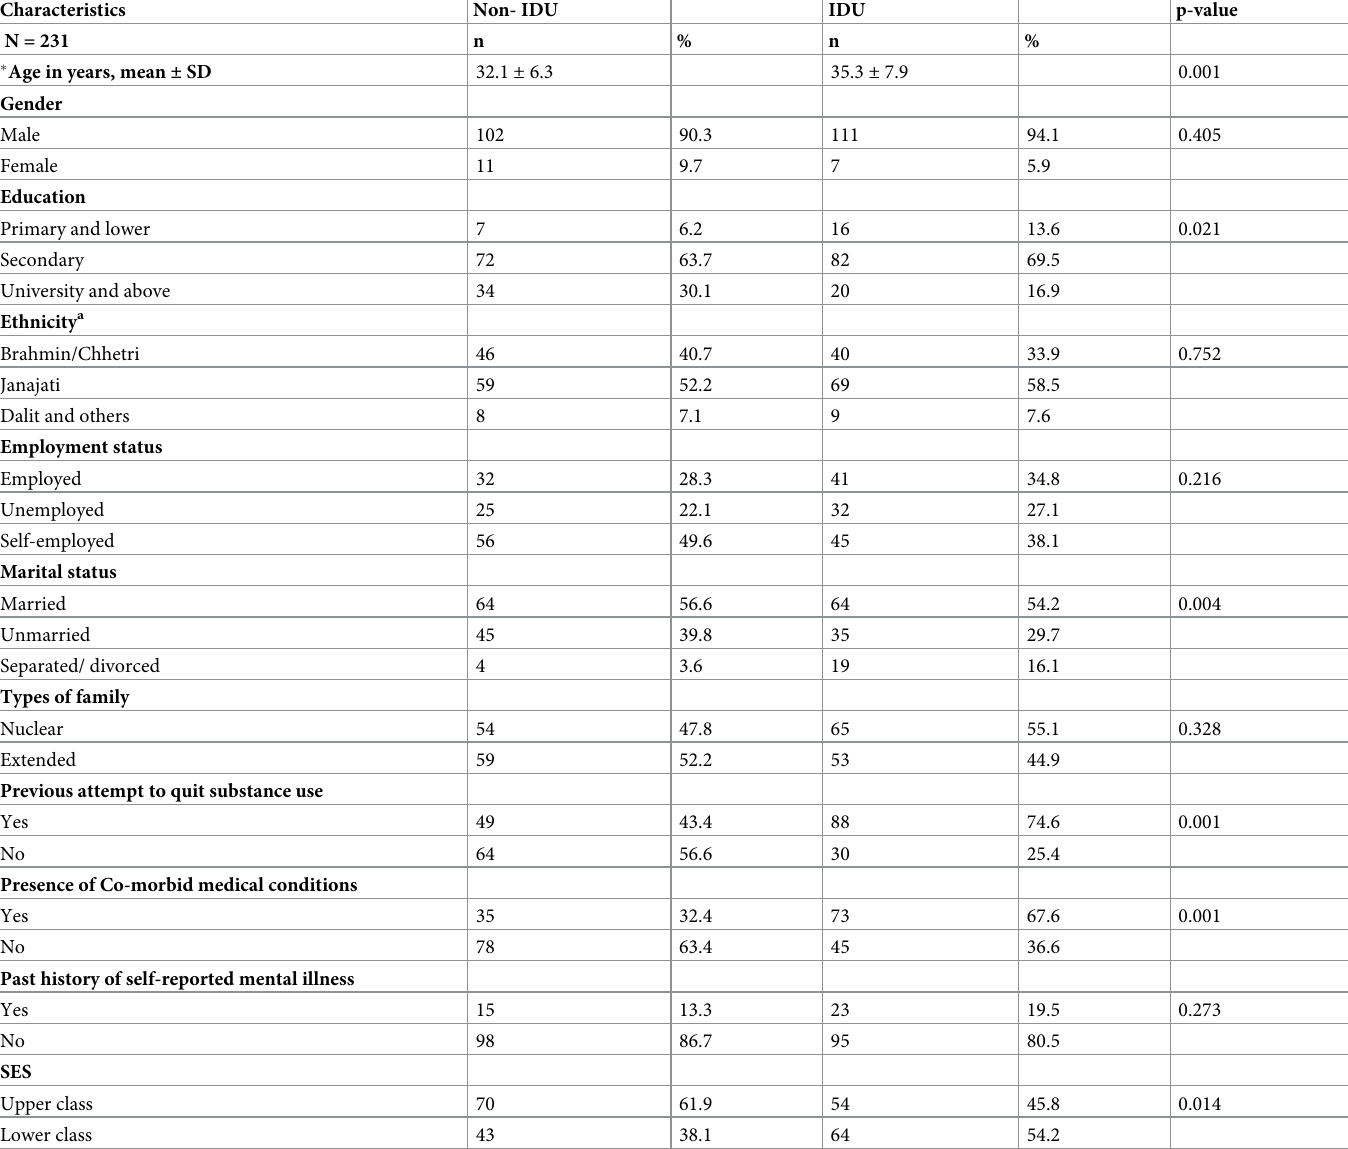
Table 1. Socio-demographic characteristics of non-injecting (non-IDU) and injecting drug users (IDU).